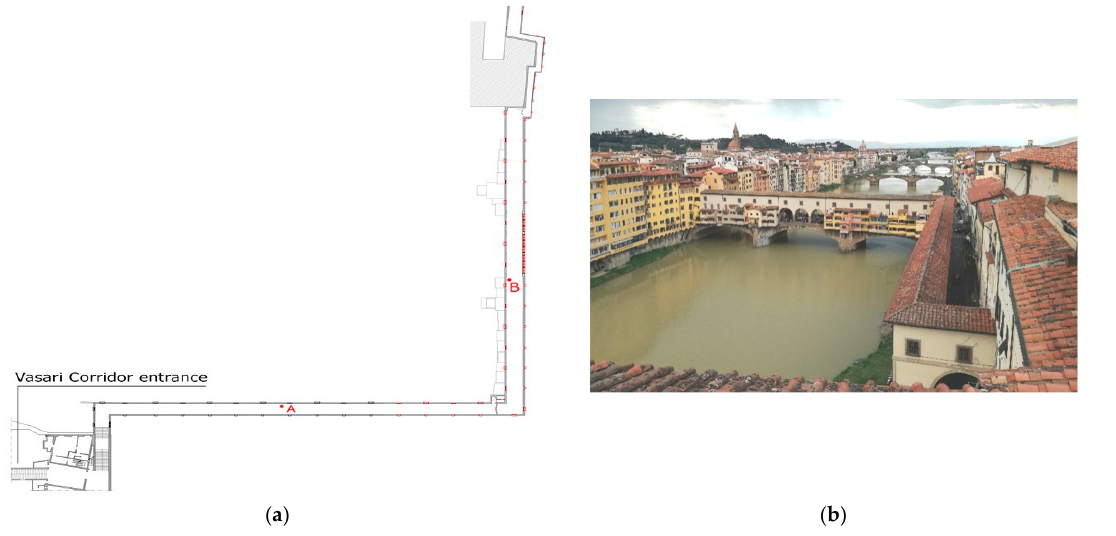
Figure 2. ( a ) Plan with the monitored zones (position A—Lungarno, and position B—Ponte Vecchio) highlighted; ( b ) a view of Vasari Corridor.